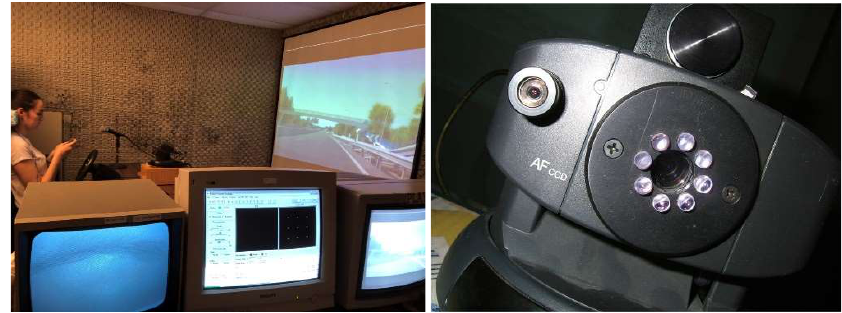
Figure 5. Driver simulator ( left ) and equipment for assessing driver activation level ( right ).